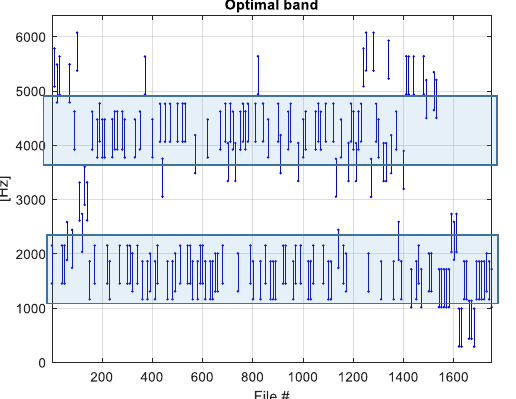
Figure 10. Definition of the optimal frequency band for filtering the residual signal according to the RCC index—right TB.